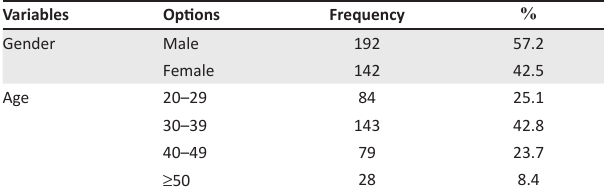
TABLE 3: Respondents biostatistics.